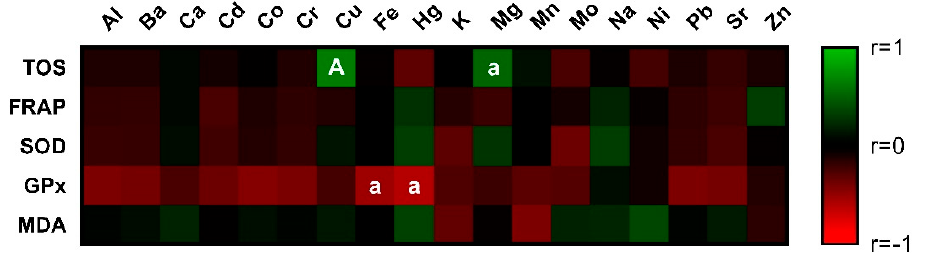
Figure 1. Correlations: chemical elements vs. markers of oxidative stress. The level of significance: a ( p < 0.05); A ( p < 0.01).